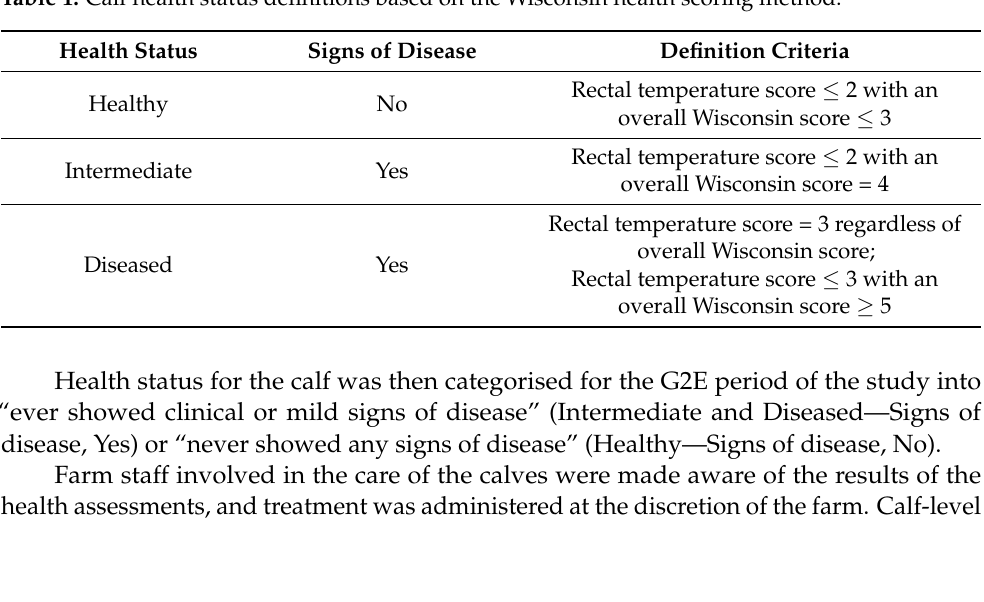
Table 1. Calf health status definitions based on the Wisconsin health scoring